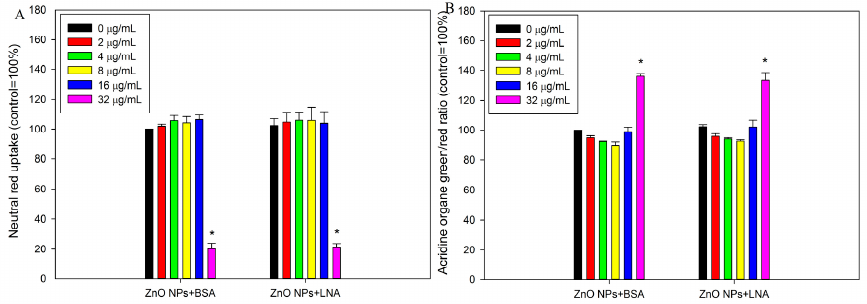
Figure 7. The damage of lysosomes as assessed by neutral red uptake assay ( A ) or acridine orange staining ( B ). HepG2 cells were exposed to various concentrations of ZnO NPs (code: XFI06) with the presence of bovine serum albumin (BSA) or α -linolenic acid (LNA; complexed to BSA; referred to as LNA) for 24 h ( A ) or 3 h ( B ), and neutral red uptake assay ( A ) or acridine orange staining ( B ) were used to indicate the integrity of lysosomes. * p < 0.01, ANOVA, compared with control.